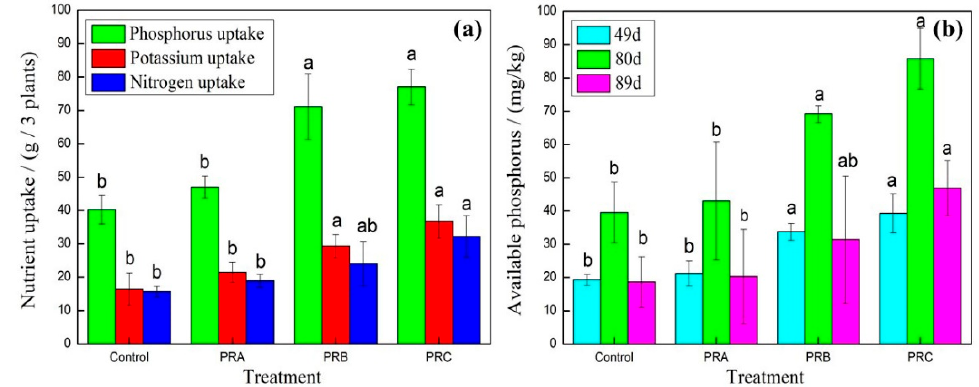
Figure 10. The P, K, and N uptake content ( a ) and available P in soils ( b ) of samples that underwent different treatments [reported values are statistically significant (p < 0.05)].